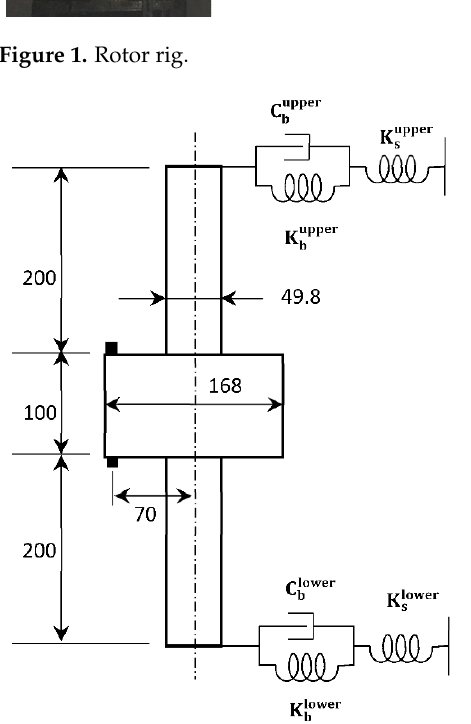
Figure 2. Schematic representation of the rotor rig. All dimensions are given in mm. Table 1. Technical specification of the rotor rig.